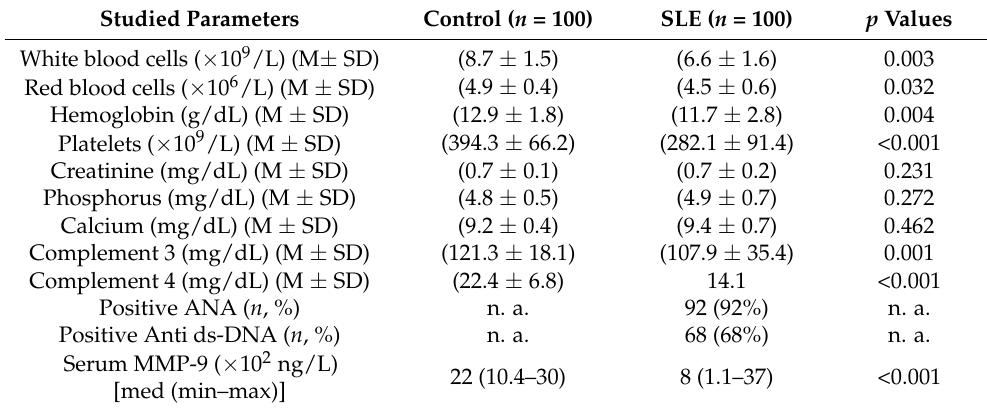
Table 2. Laboratory investigations of SLE (systemic lupus erythematosus) patients and healthy control subjects. Studied